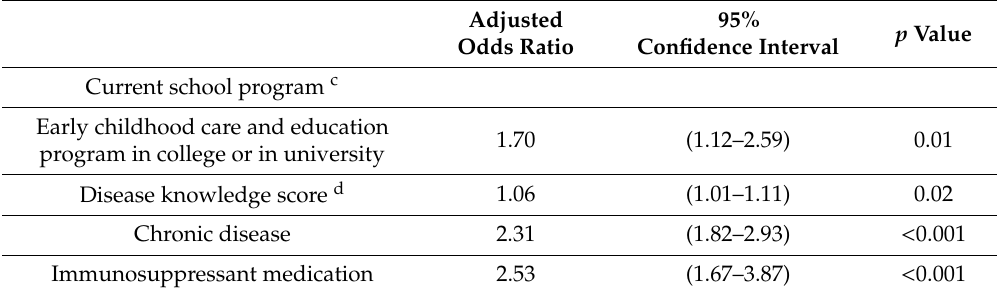
(Table 3. Likewise, higher desire to flatten the curve of disease (aOR 1.18, 95%CI 1.12–1.25) or to protect their family / friends (aOR 1.14, 95% CI 1.05–1.24; p = 0.002) were also associated with a greater level of adherence to preventive measures (Table 3). Table 2. Factors associated with high COVID-19 disease risk perception a,b .